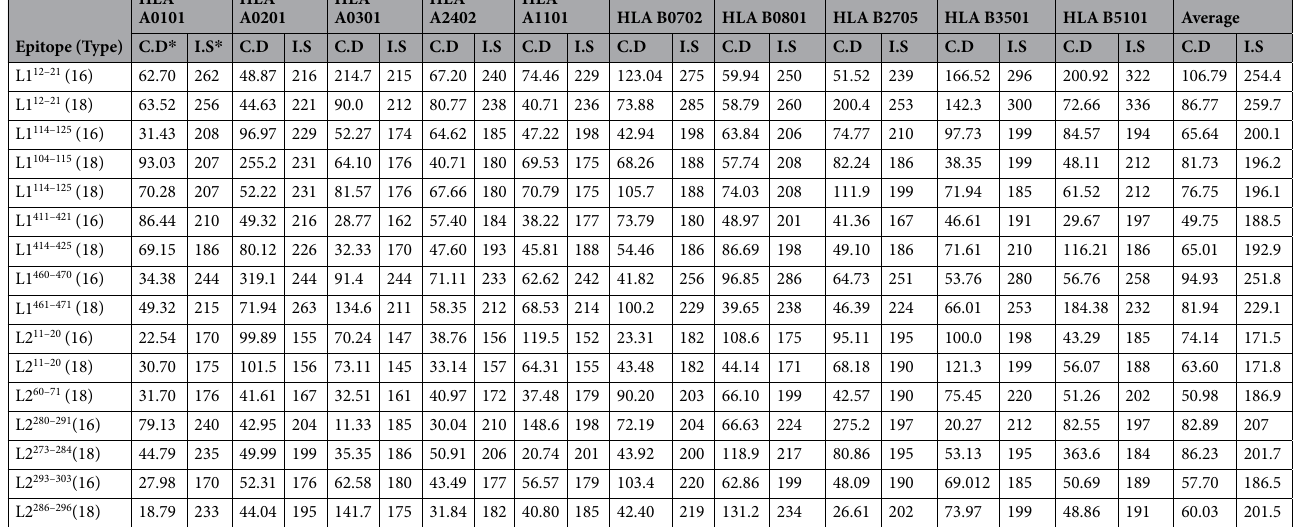
Table 11. MHC-I -peptide docking scores of selected CTL epitopes. * higher rate shows better quality of peptide-MHC